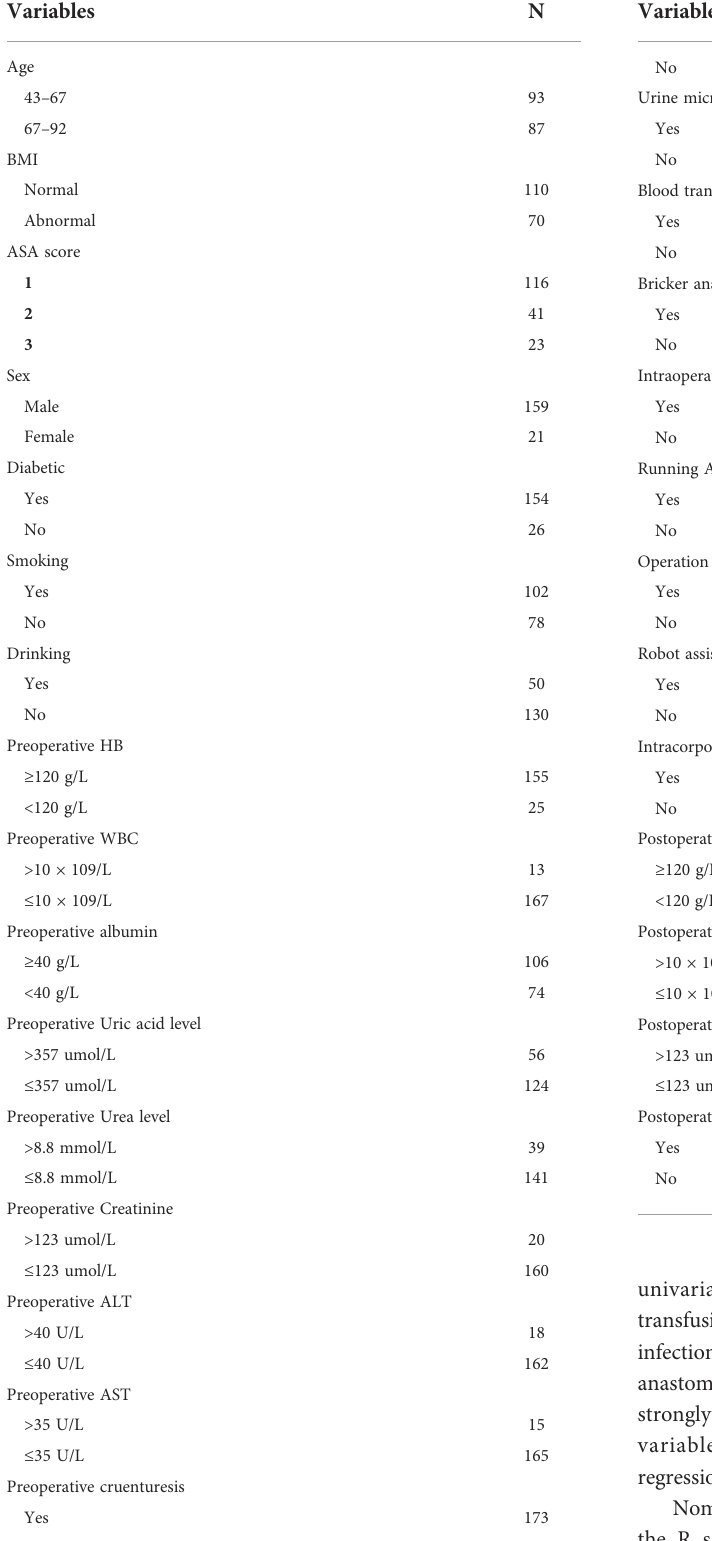
TABLE 2 Summary of categorical variables